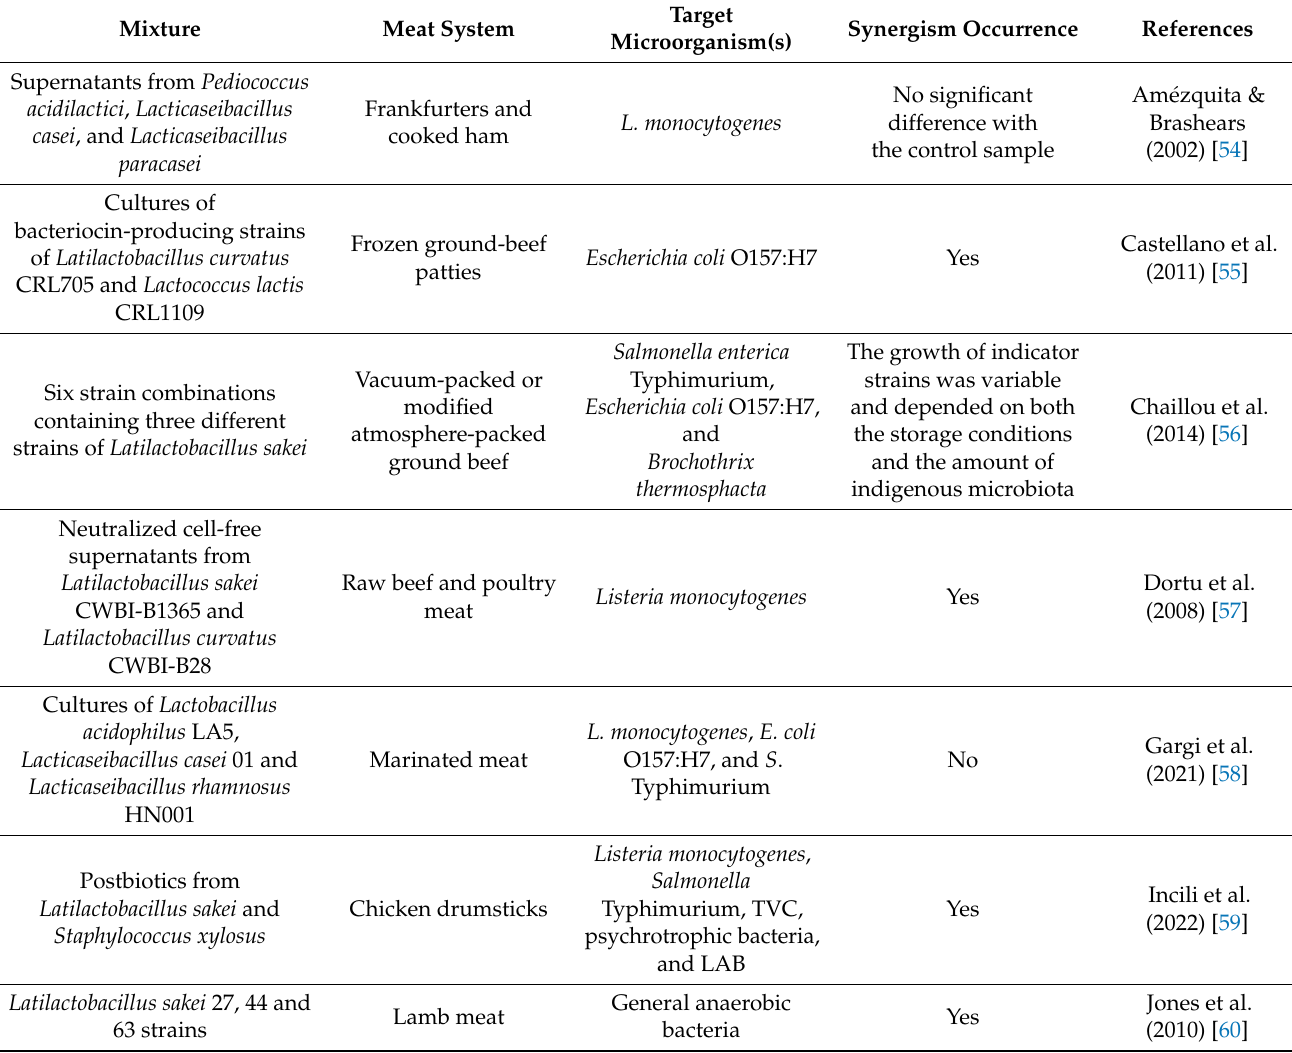
Table 2. The use of diverse combinations of non-starter protective cultures against different target